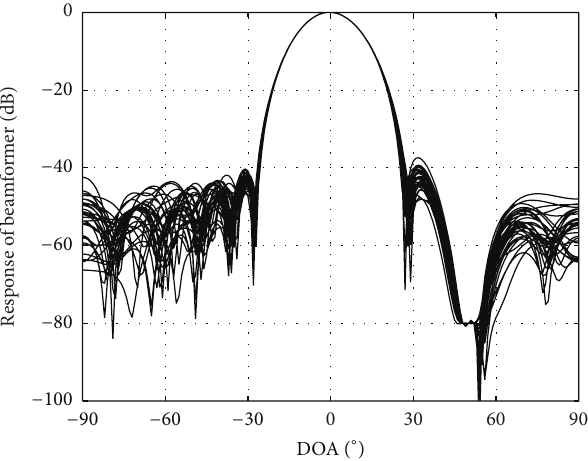
Figure 2: Response of beamformer with proposed method 1.